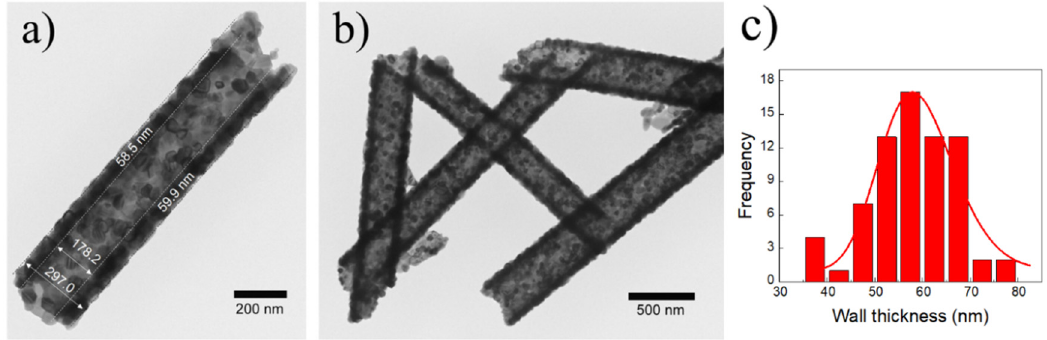
Figure 2. TEM images of ZnO NT (500 ALD cycles and 450 °C as calcination temperature) at different